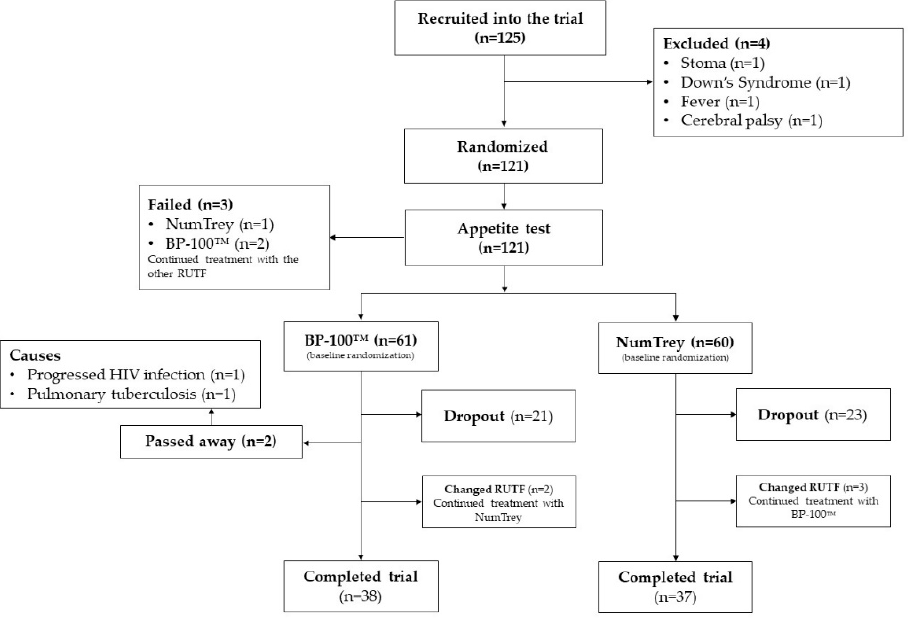
Figure 1. Flowchart of patient’s enrolment into the trial.